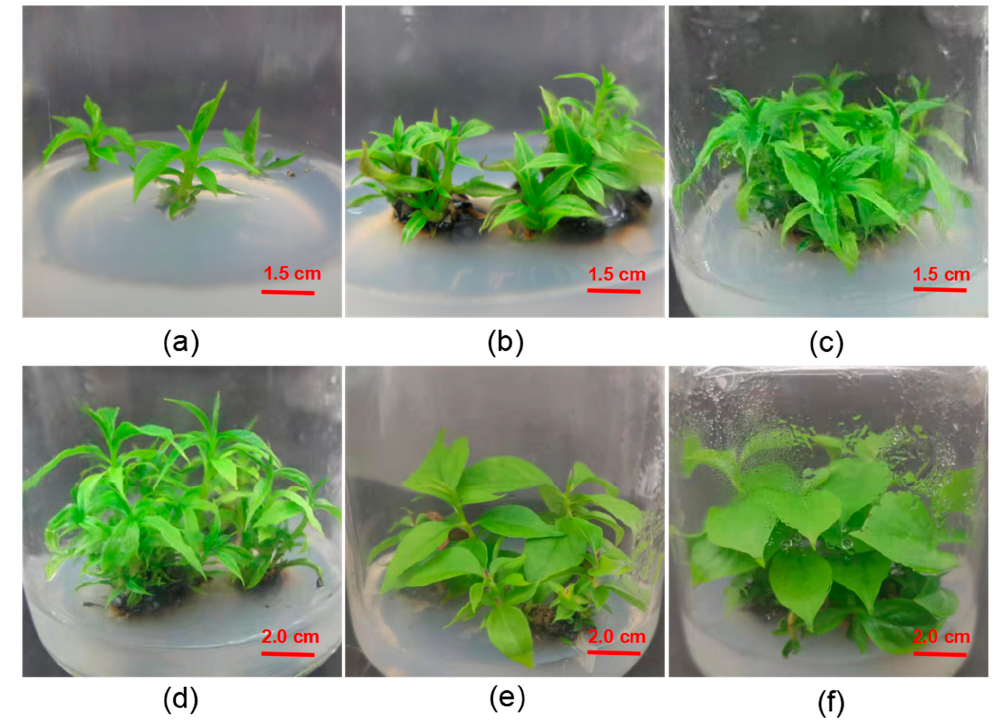
Figure 6. D. lotus subsequent proliferation culture. ( a ) Single adventitious shoots were incorporated into the medium. ( b ) Clump stems grew after 10 days. ( c , d ) Growth status of migration after 25